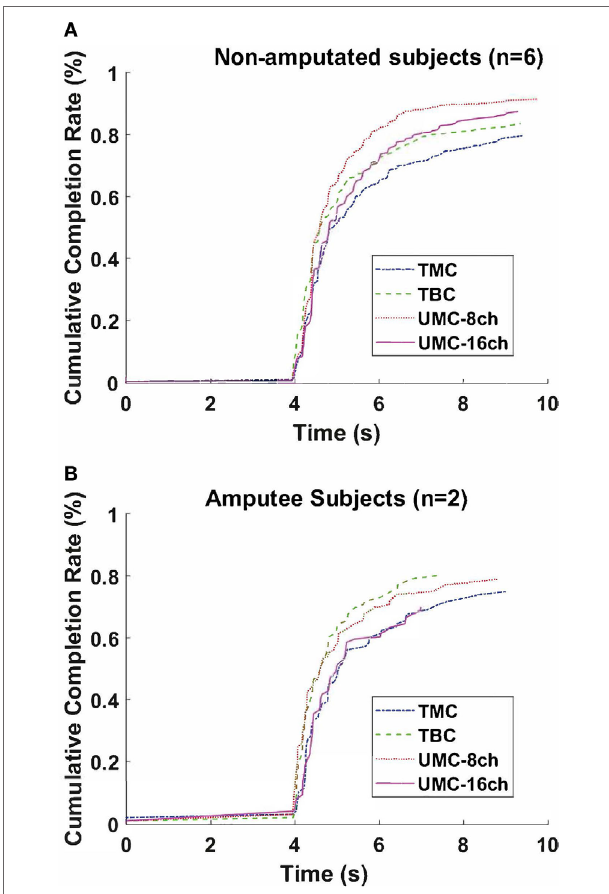
FigUre 6 | Cumulative completion rate for (a) non-amputated and (B) amputated